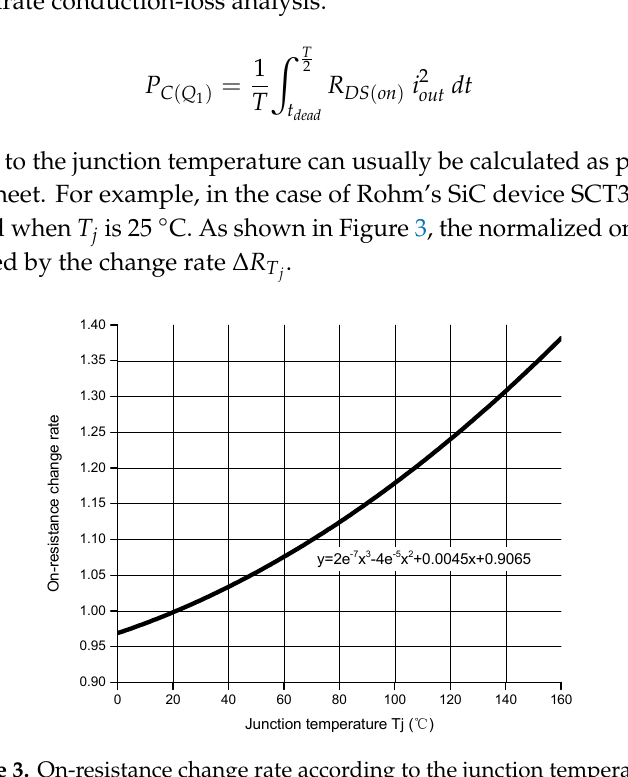
Figure 3. On-resistance change rate according to the junction temperature.